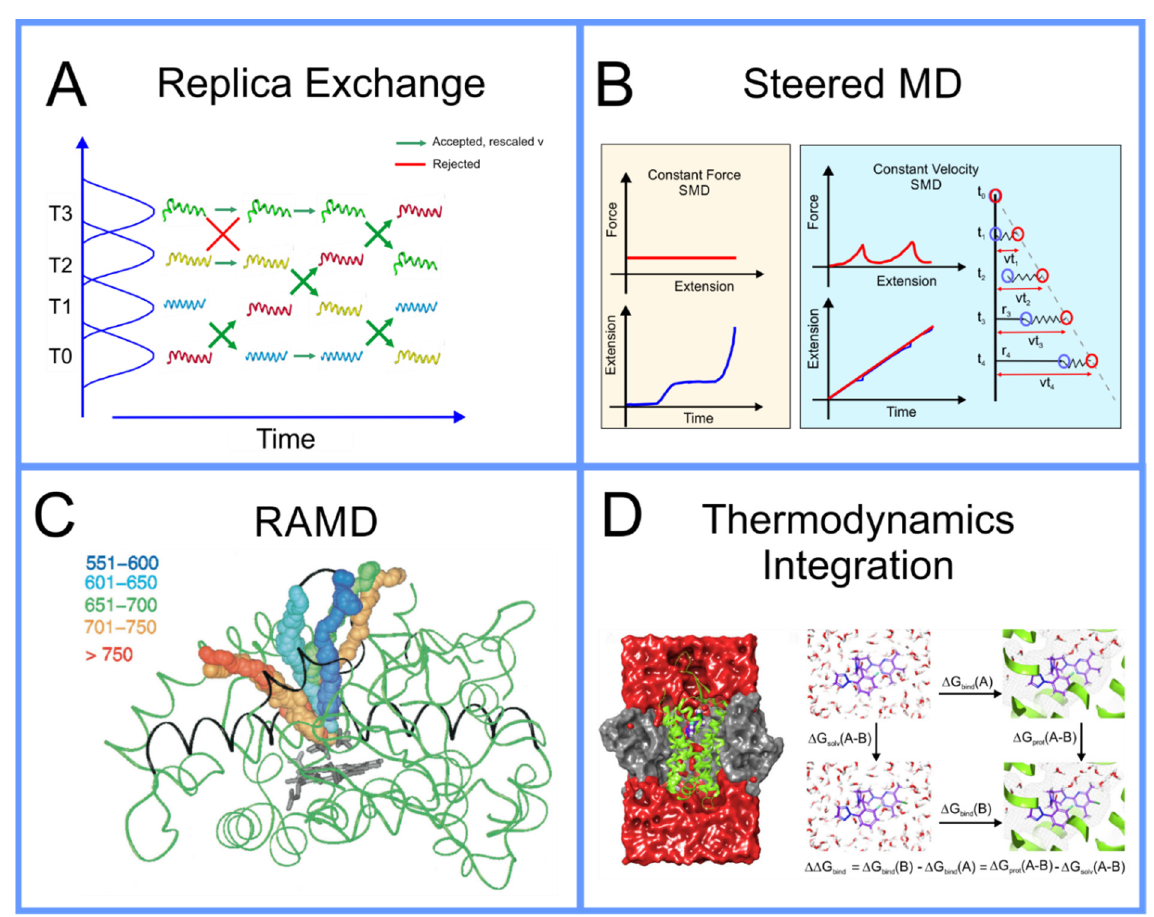
Figure 3. ( A ) Schematic representation of replica exchange (based on ref. [28]); ( B ) force bias/Jarzynsky, reproduced with permission from ref. [94]; ( C ) RAMD, reproduced with permission from ref. [102]; ( D ) thermodynamics integration, reproduced with permission from ref. [103].